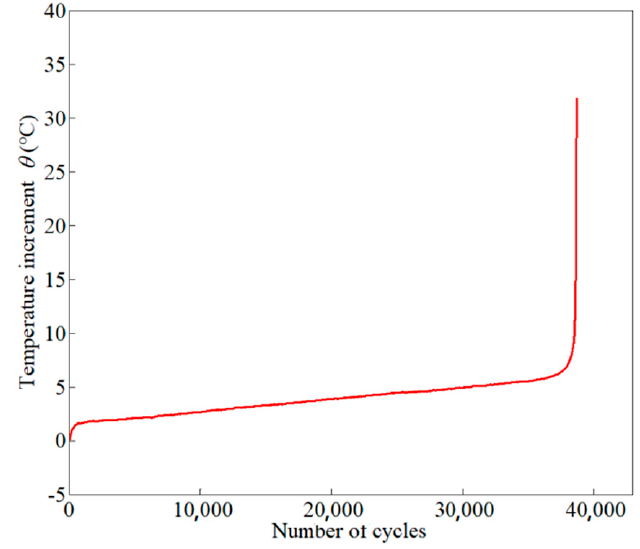
Figure 7. The thermal evolution in whole life cycles under stress amplitude 300 MPa.